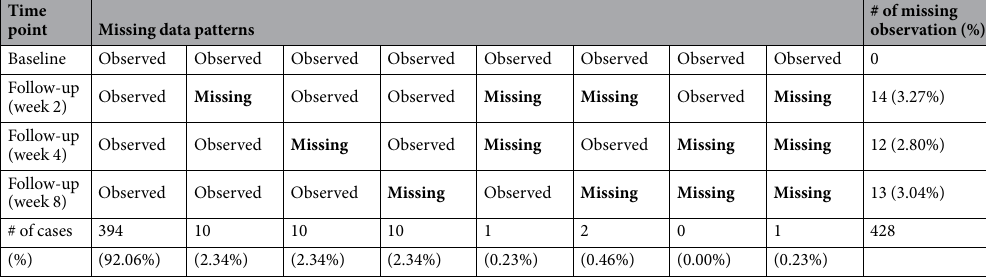
Table 1. The patterns of missing data in phenotypes (N = 428). a Missing represents missing value in all the 21- item Hamilton Rating Scale for Depression.